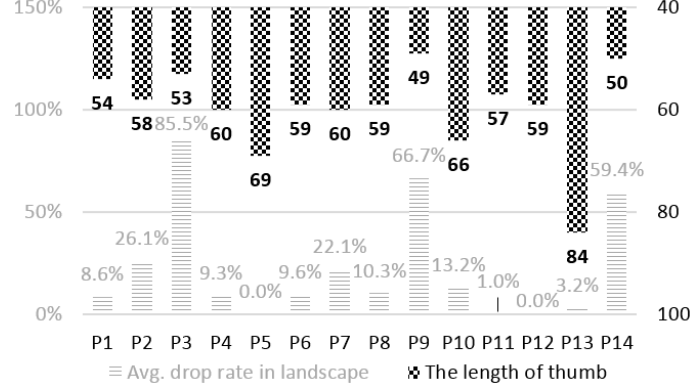
Figure 9. The average drop rate and thumb length of the participants.